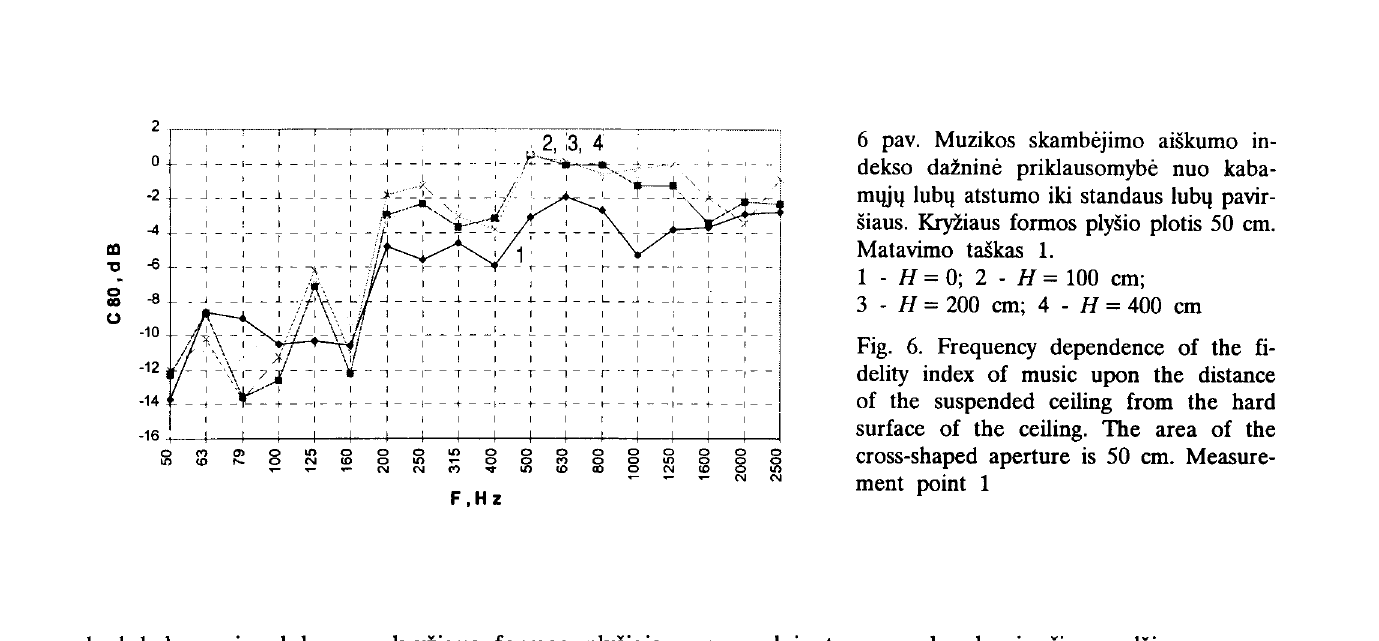
Fig. 6. Frequency dependence of the fi delity index of music upon the distance of the suspended ceiling from the hard surface of the ceiling. The area of the cross-shaped aperture is 50 em. Measure ment point